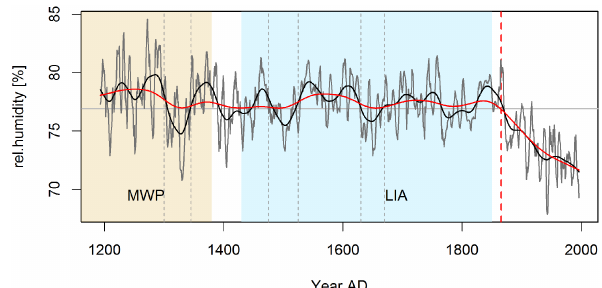
Figure 4. Summer (July + August) relative humidity reconstruction AD1193–1996 for the eastern TP. Solid black and red lines rep- resent 50-year and 150-year smoothing splines, respectively. Red dashed line emphasizes the turning point towards drier conditions ( ∼ 1870s). The horizontal gray line illustrates mean relative sum- mer humidity (RH = 72.4%). Vertical dashed lines mark relatively dry periods. The Medieval Warm Period (MWP) and Little Ice Age (LIA) are emphasized in yellow and